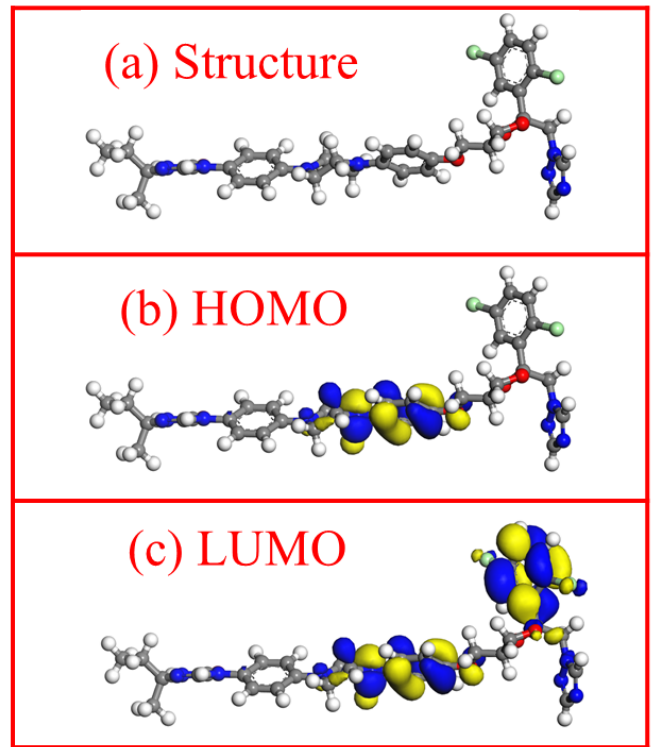
Figure 10. Itraconazole molecule after optimization ( a ), the HOMO orbital ( b ), and the electron cloud distribution of the LUMO orbital ( c ).